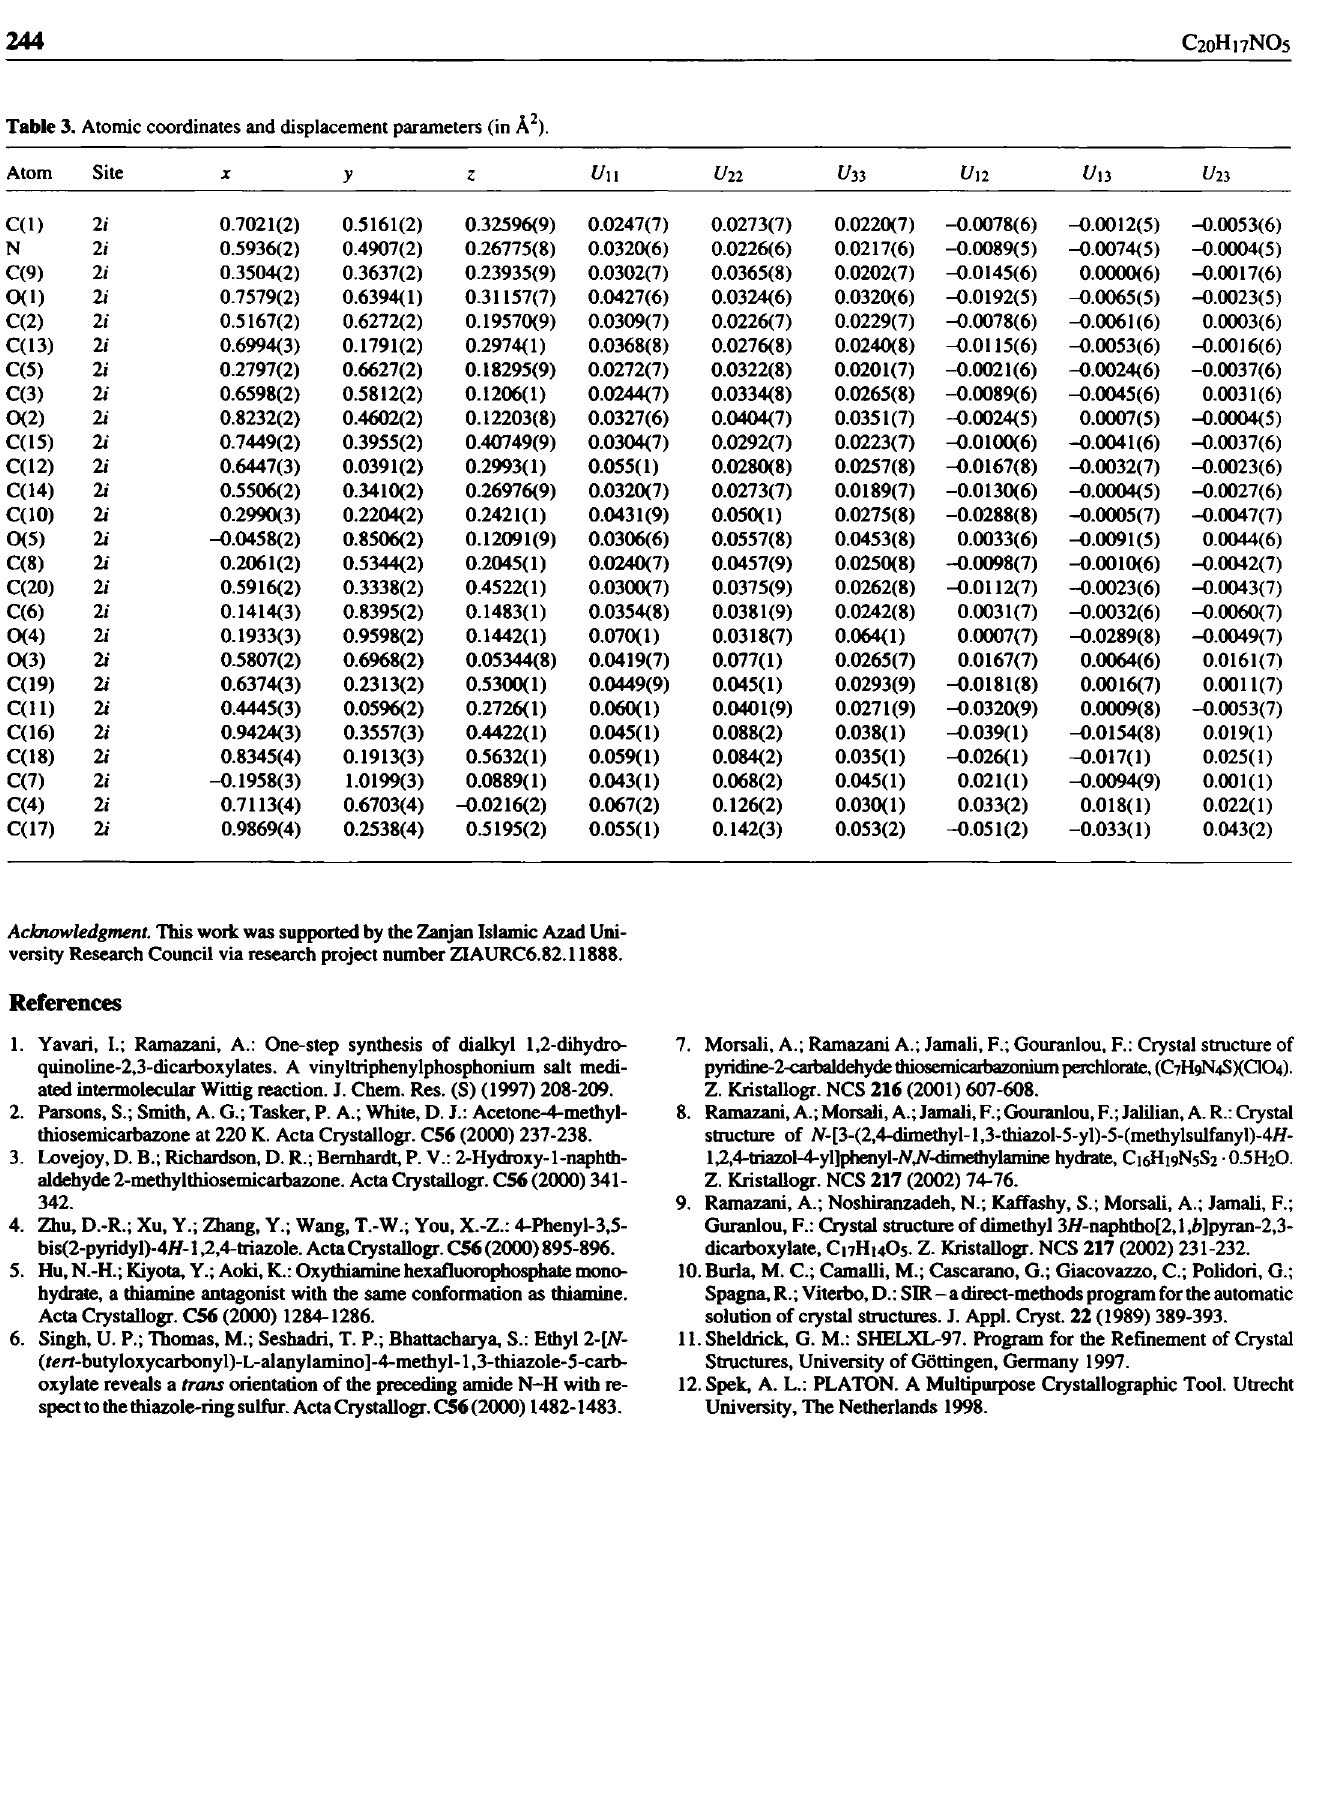
Table 3. Atomic coordinates and displacement parameters (in Â 2